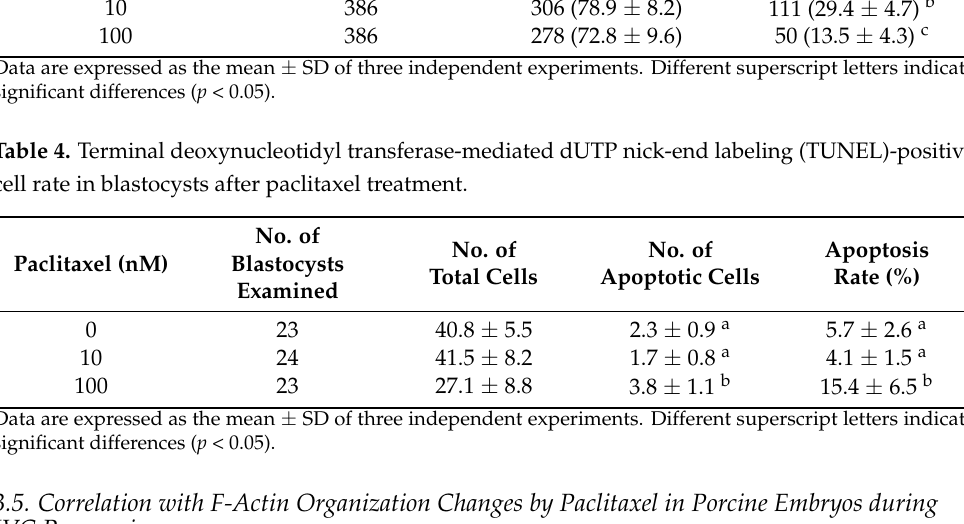
Table 3. Percentage of fertilization and blastocyst formation after paclitaxel treatment. Paclitaxel No. of Oocytes No. of Cleaved No. of (nM) Examined Embryos (%) Blastocysts (%) Control 382 273 (72.0 ± 8.0)